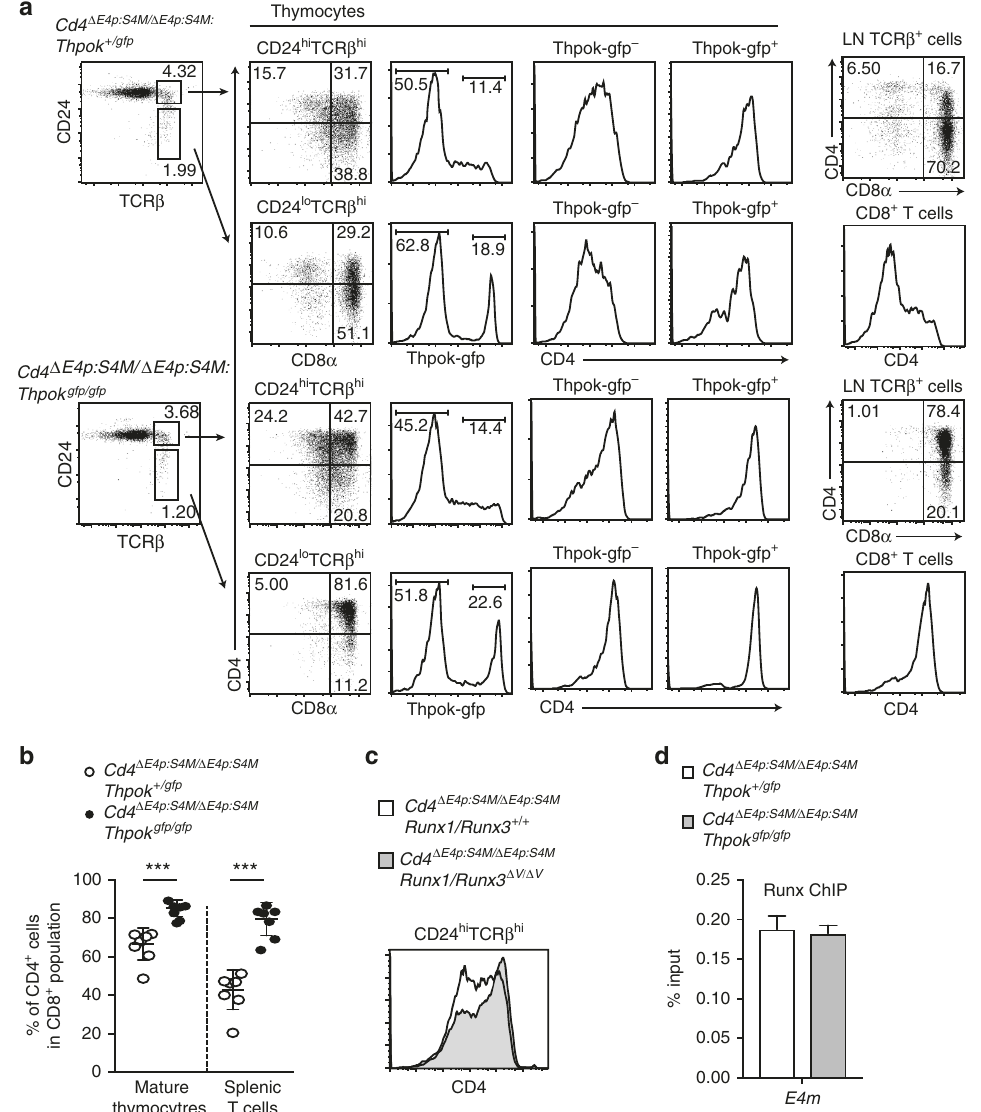
Fig. 7 ThPOK is necessary for Runx-mediated repression of E4m activity. a Flow cytometry analyses for CD4, CD8 and Thpok-gfp expression during T cell development in Cd4 Δ E4p:S4M/ Δ E4p:S4M mice in the presence or absence of ThPOK. Numbers in quadrants, indicated gate, and the region in histograms indicate respective cell percentages. b Summary of percentage of CD4 + cells in CD8 + mature thymocytes and CD8 + splenic T cells of Cd4 Δ E4p:S4M/ Δ E4p: S4M : Thpok + /gfp and Cd4 Δ E4p:S4M/ Δ E4p:S4M : Thpok gfp/gfp mice. Means ± SD. *** p < 0.001 (unpaired student t test, two-sided). c Histogram showing CD4 expression in freshly selected (CD24 hi TCR β hi ) thymocytes of Cd4 Δ E4p:S4M/ Δ E4p:S4M : Runx1/Runx3 + / + and Cd4 Δ E4p:S4M/ Δ E4p:S4M : Runx1/Runx3 Δ V/ Δ V mice. One representative of two independent analyses. d Graph showing summary of three independent ChIP-qPCR experiments for Runx bindings to E4m in pre-selection DP thymocytes from Cd4 Δ E4p:S4M/ Δ E4p:S4M : Thpok + /gfp and Cd4 Δ E4p:S4M/ Δ E4p:S4M : Thpok gfp/gfp mice. Means ±